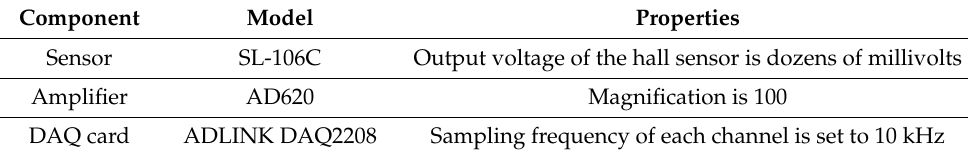
Figure 9. Experimental system. Table 1. Specifications of the experimental Table 1. Specifications of the experimental system.